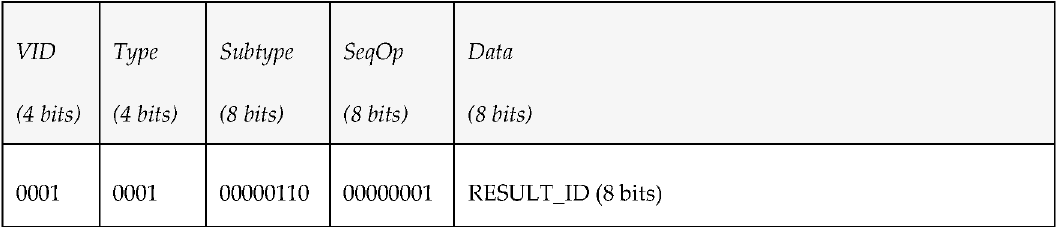
Figure 10. Appearance of the PDU used as an answer for the task reported. Figure 9. Appearance of the PDU used for area cover request. Figure 9. Appearance of the PDU used for area cover request.